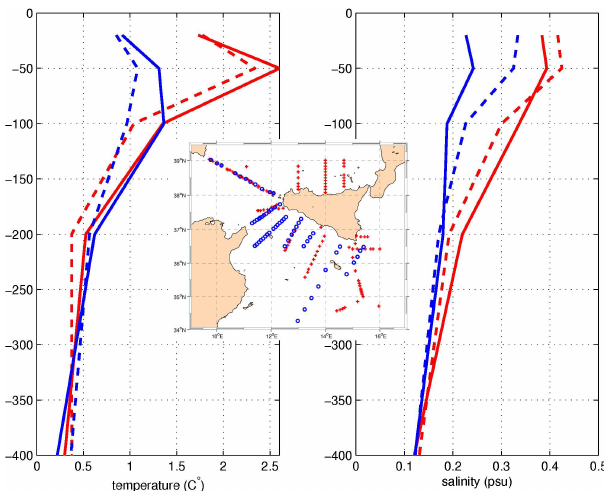
Fig. 9. RMSE profiles for AN (dashed) and SIM (full) vs. CTD Fig.9. RMSEprofilesforAN(dashed)andSIM(full)vsCTDobservationscollectedinAugust(red)andNovember2009(blue).Leftpanel fortemperature,rightforsalinity.ThelocationsofCTDstationsarealsoshowninthereferencemap. observations collected in August (red) and November 2009 (blue). Left panel for temperature, right for salinity. The locations of CTD stations are also shown in the reference map.